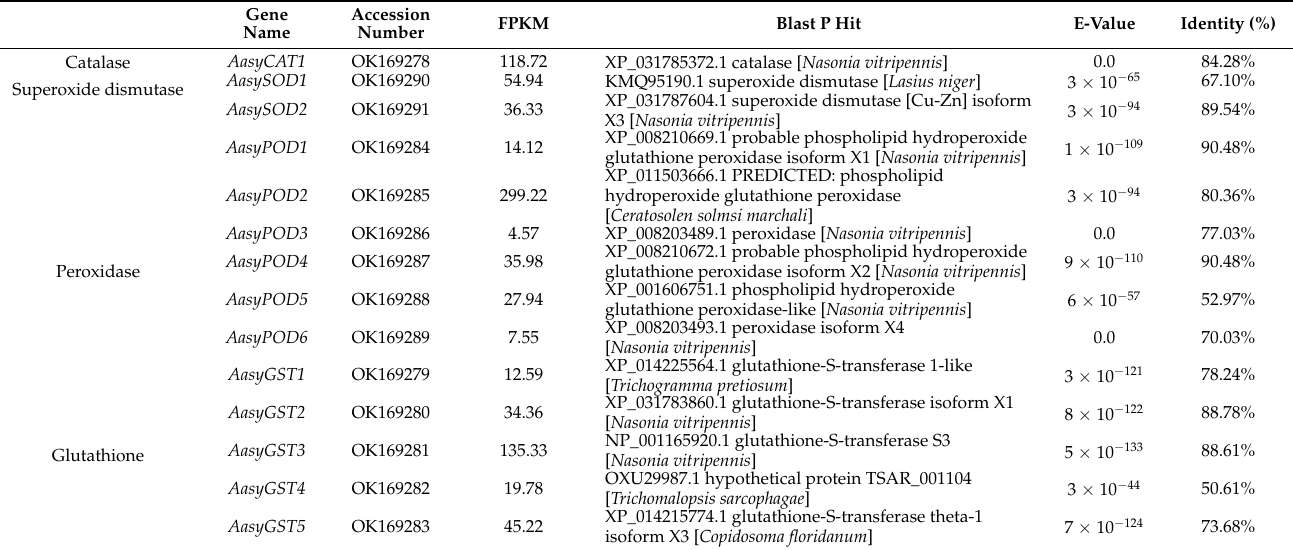
Table 1. The identified antioxidant enzyme-related genes in A. asychis .